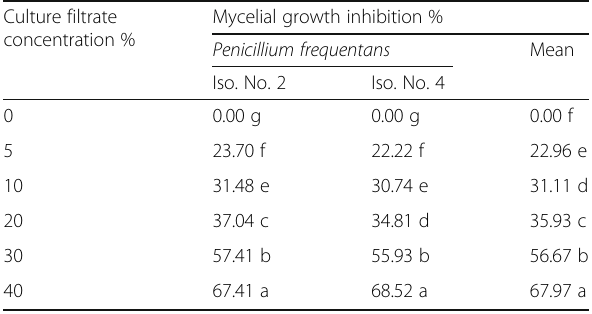
Table 1 Effect of different concentrations of culture filtrate of Penicillium frequentans isolates on mycelial growth of Cercospora beticola in vitro Culture filtrate Mycelial growth inhibition % concentration % Penicillium frequentans